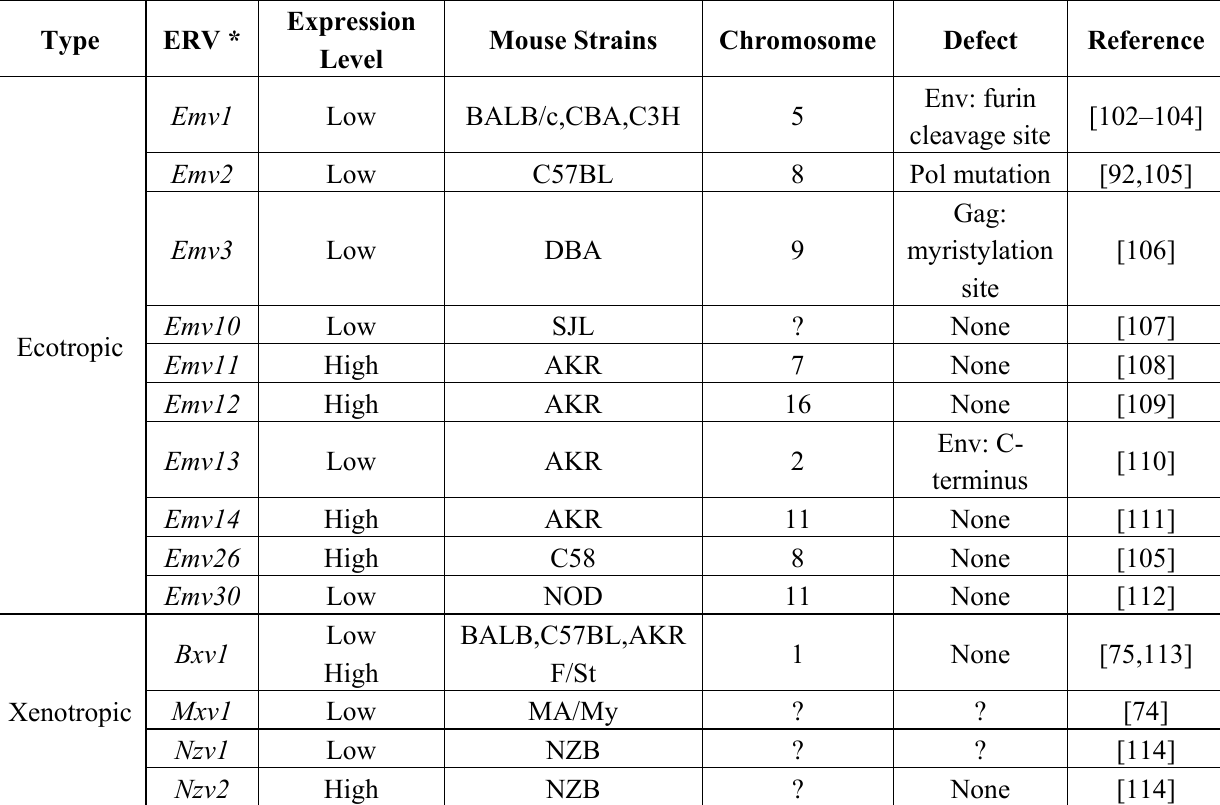
Table 3. MuLV ERVs that produce infectious